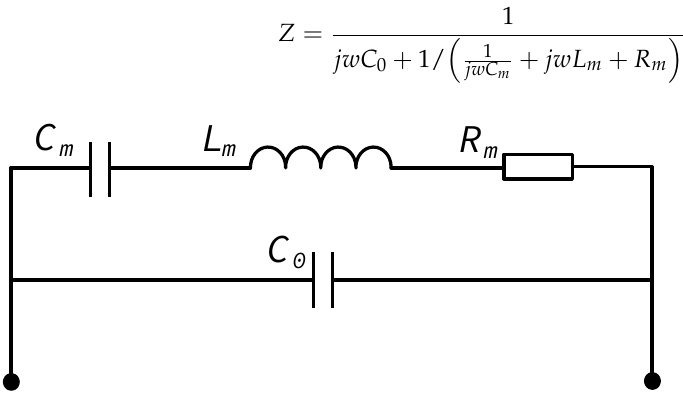
Figure 3. BVD model of a piezoelectric resonator.